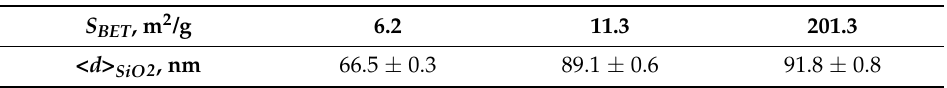
Table 2. Crystallite size (< d > SiO2 ) dependence on specific surface area of powders ( S BET ), 0.4 nm/s deposition rate, 600 ◦ C temperature of SiO 2 substrate.